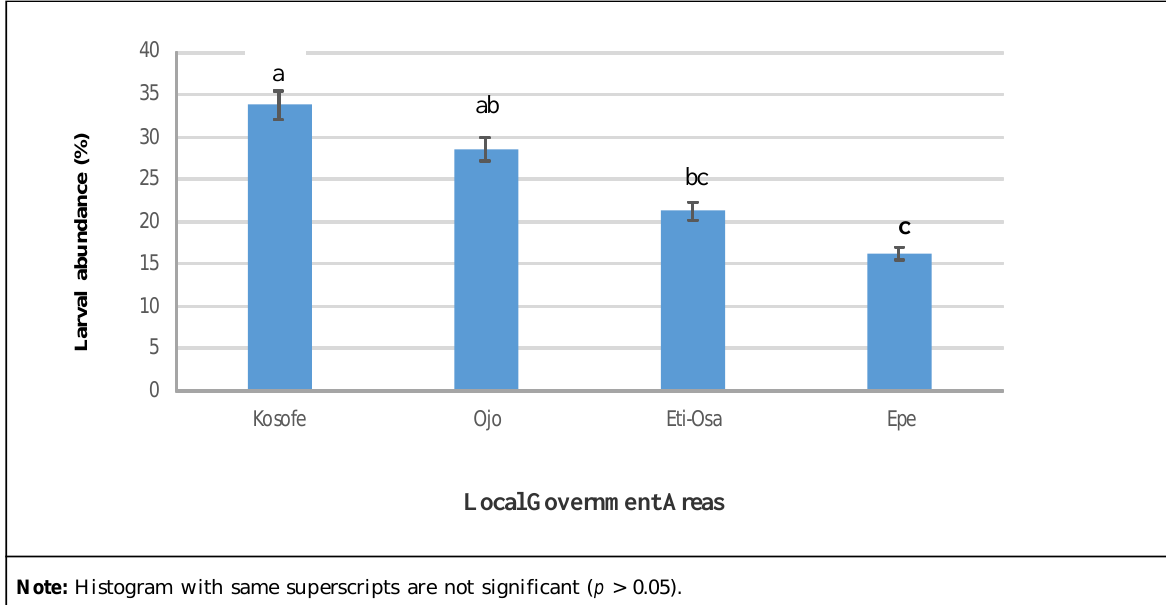
Figure 2: Culex larvae distribution in the four LGAs of Lagos The emerged adults were morphologically identified as Cx. quinquefasciatus (61.9%) of the Cx. pipiens complex, while other species observed included Cx. decens (10.0%), Cx. nebulosus (6.9%), Cx. cinereus (12.0%), Cx. tigripes (3.9%) and Cx. duttoni (5.3%). The results of PCR analysis of members Cx. pipiens complex revealed Cx. quinquefasciatus as the only sibling species (Figure 3).